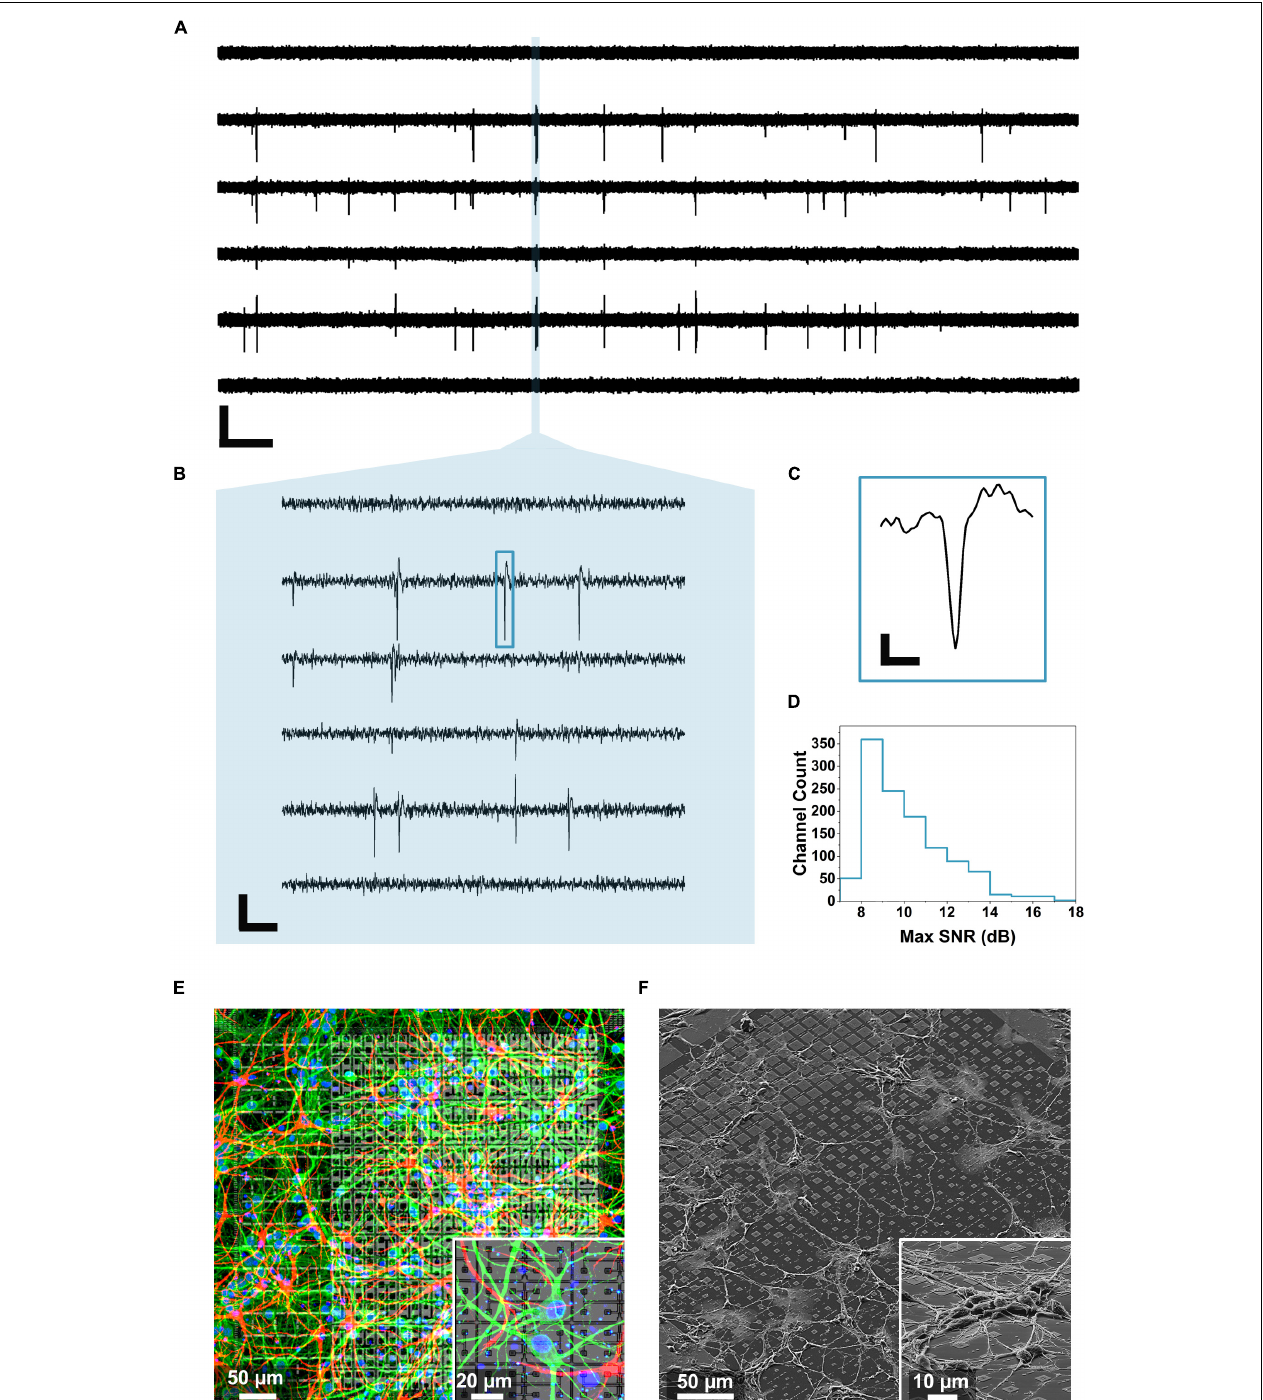
FIGURE 3 | Neuronal voltage recordings and microscopy. (A) Raw traces of the spontaneous electrical activity recorded from primary hippocampal neurons at 15 DIV on 6 of the 1024 electrodes for 30 s (scale bar: 400 µ V vertical, 2 s horizontal). (B) Zoom over 100 ms of the recorded spontaneous activity unveiling individual spikes (scale bar: 200 µ V vertical, 10 ms horizontal). (C) Profile of an individual spike corresponding to the blue rectangle in B (scale bar: 100 µ V vertical, 0.5 ms horizontal). (D) Maximum SNR calculated from 1024 electrodes during five sequential recordings according to the method described in Section “Data Analysis” and showing an average SNR of 10.1 ± 1.9 dB. (E) Immunostaining of a 14 DIV primary hippocampal neuron culture on a single active area of the chip and on a zoomed area (inset). The MAP2 immunostaining mapping neurons can be observed in green, the GFAP mapping the glia present in the culture is reported in red while the nuclei are shown in blue (DAPI). (F) SEM images of a 3 DIV primary hippocampal neuron culture on a single active area and on a zoomed region (inset) of the CMOS chip.